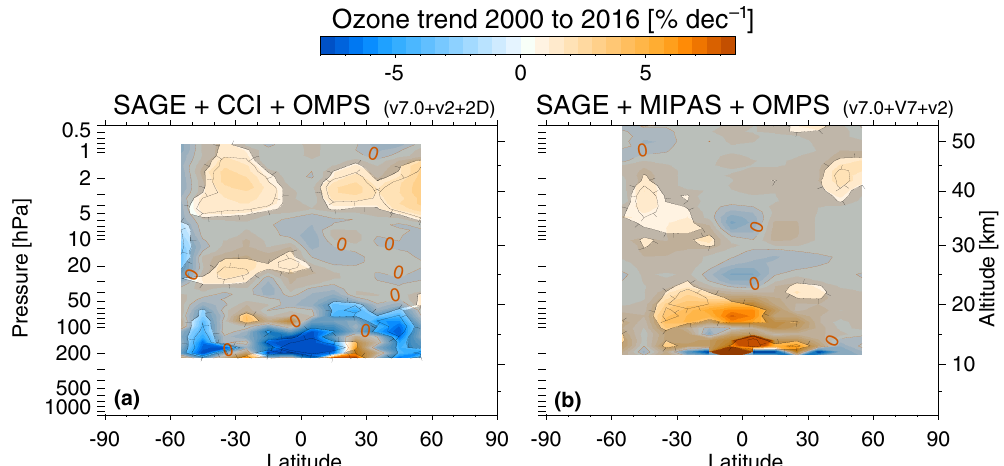
Figure 3. Same as Fig. 2, but showing the 2000 to 2016 ozone trends for the merged SAGE–ESA Ozone CCI–OMPS, and SAGE–MIPAS– OMPS data sets. The SAGE–ESA Ozone CCI–OMPS data set uses the OMPS 2-D retrieval from U. Saskatoon. The SAGE–MIPAS–OMPS data set uses the OMPS v2 retrieval from